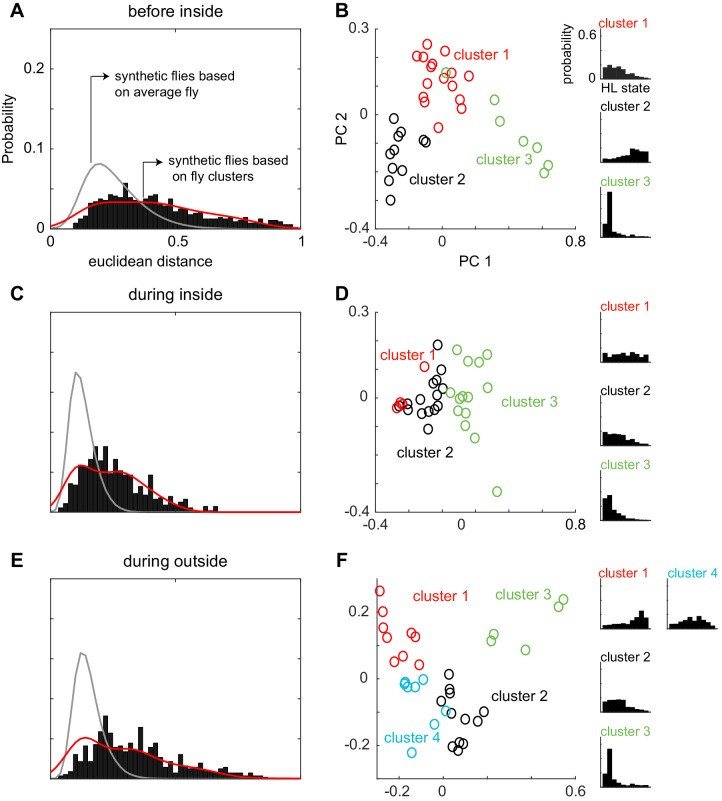
Flies can be clustered into three to four types based on their locomotion.This figure shows the same analysis as in Figure 7, but for the other three conditions - before inside, during inside and during outside (A) Same as Figure 7A and B, but for "before inside". Average fly (gray line, Wilcoxon rank sum, p < 9.57e-58). Cluster fly (Wilcoxon rank sum, p < 4.13e-3). (B) X-means clustering (a variant of K-means) based on the 10-dimensional space formed by the HL states show that there are three clusters of flies in the ‘before inside’ section. The first two PCs are shown for visualization. Each cluster is represented by a different color. Average HL state distribution for each cluster is shown on the right. (C and D) Same as A and B but for ‘during inside’. Average fly (Wilcoxon rank sum, p < 3.25e-86). Cluster fly (Wilcoxon rank sum, p < 0.019). (E and F) Same as A and B but for ‘during outside’. Average fly (Wilcoxon rank sum, p < 2.42e-130). Cluster fly (Wilcoxon rank sum, p < 2.40e-10).